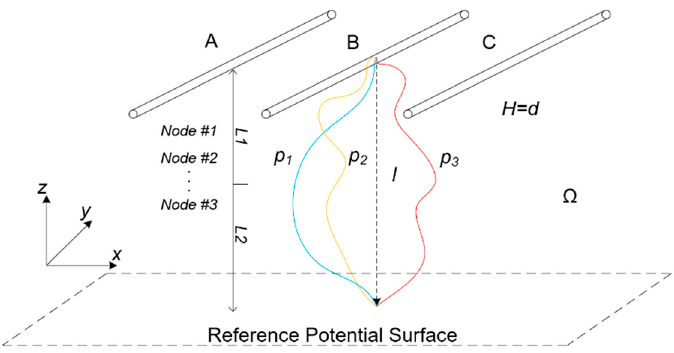
Figure 3. Schematic of the Gauss–Chebyshev integral calculation.